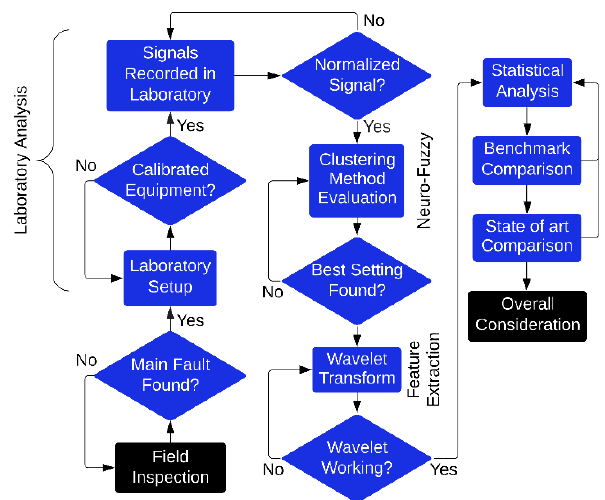
Figure 4. Method flowchart for insulator withdrawal and model evaluation.